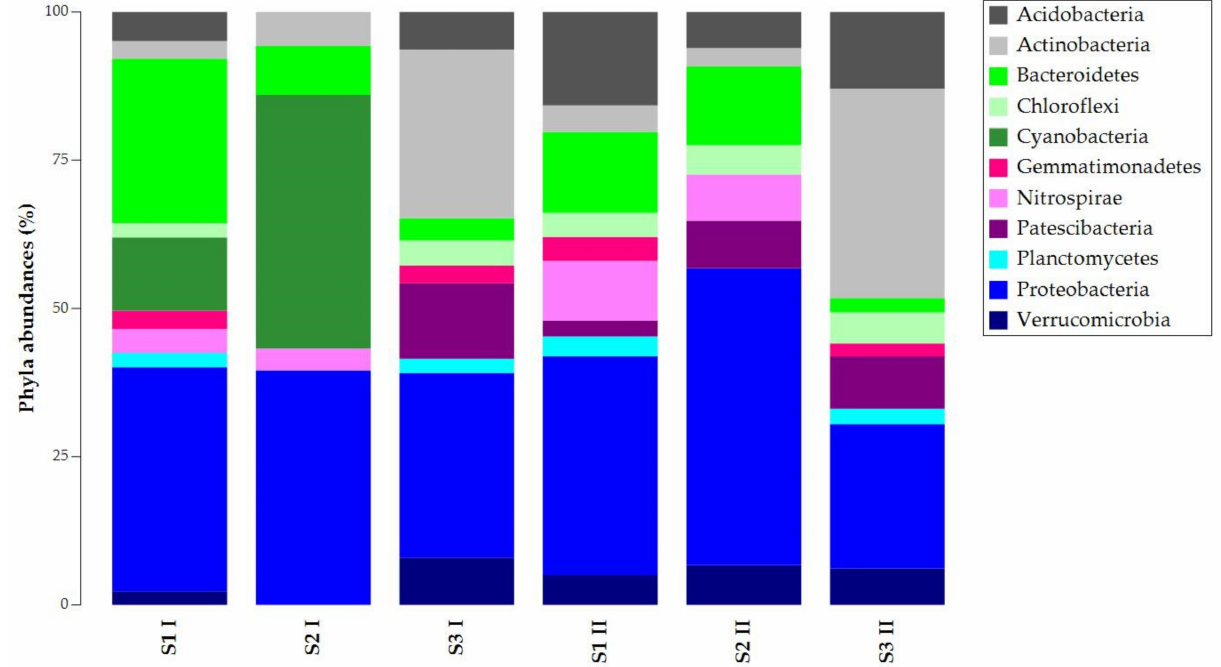
Figure 2. Taxonomy bar plot of ASVs (Amplicon Sequence Variants) at the phylum level.